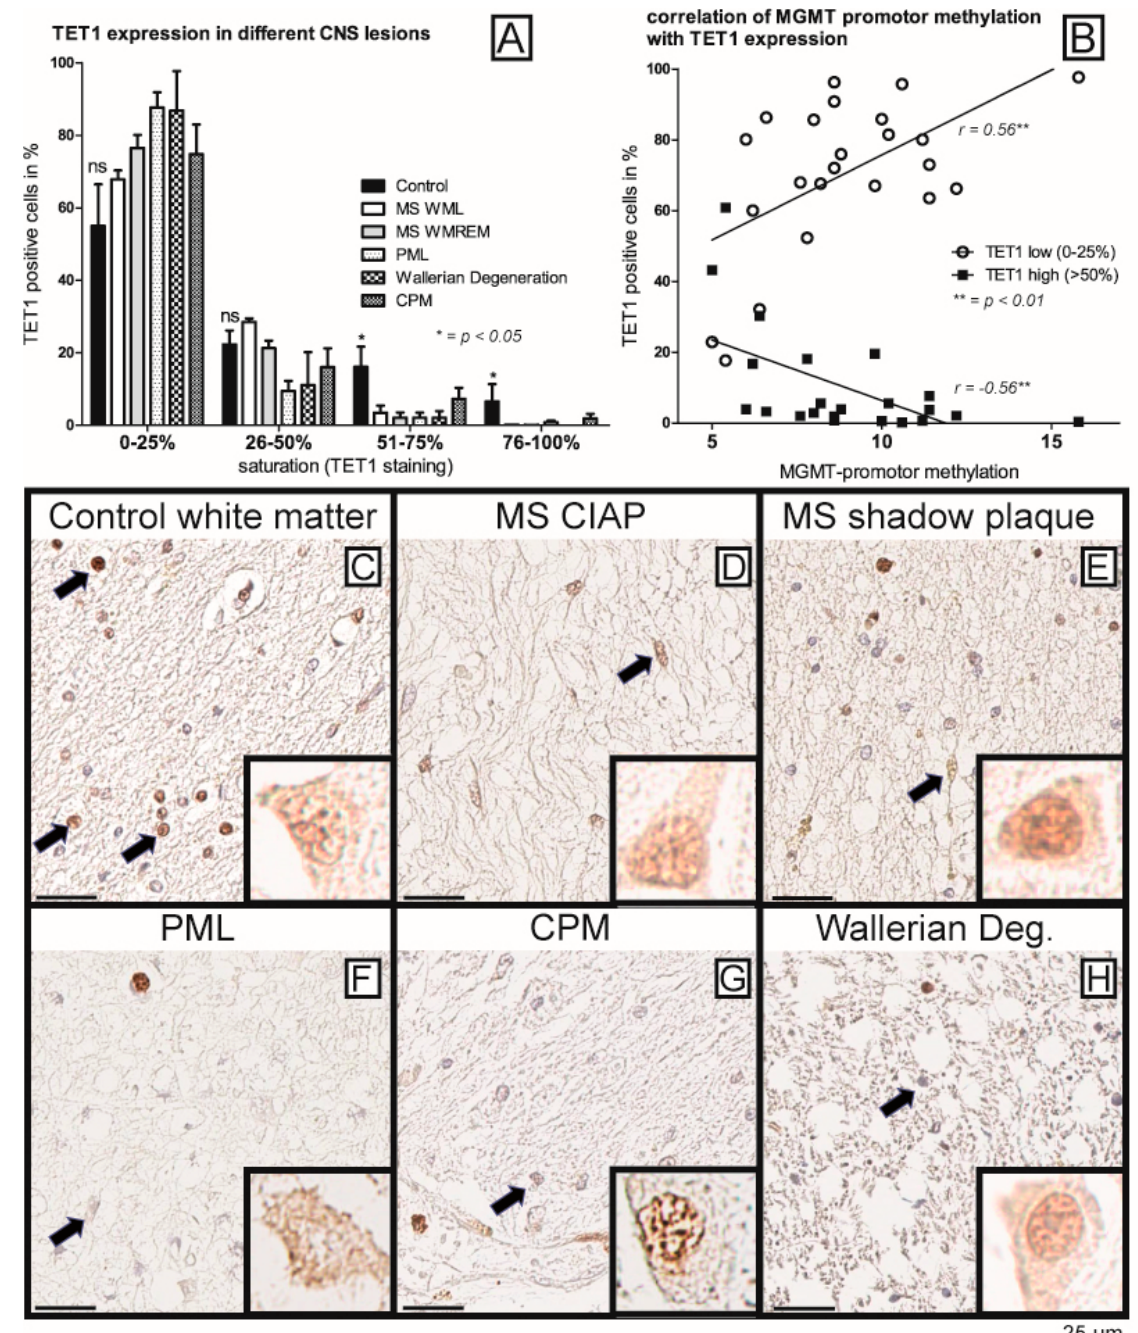
Figure 3. Reduction in TET1 staining in samples with enhanced MGMT promoter methylation. In control samples ( A , C ) a broad spectrum of TET1 expression was detectable with numerous strongly TET1-stained glial cells (arrows). In samples with enhanced MGMT methylation ( D – H ), glial cells with little or no TET1 expression were mainly detected, whereas strongly TET1-positive glial cells, i.e., glial cells with high TET1 expression were hardly detectable compared with controls ( D ). MS chronic inactive plaque, ( E ). MS shadow plaque; ( F ). PML, ( G ). CPM; ( H ). Wallerian degeneration). In all samples, the neurons in the same sections with a similar positive staining of MGMT served as an internal positive control to exclude staining artifacts (inset in ( C – H ), edge length 15 µ m each). ( B ): The subset of glial cells with strong TET1 expression (lower panel) shows a significant negative correlation (Pearson r= − 0.56, p < 0.01) with the level of MGMT promoter methylation, while vice versa the subset of glial cells with weak TET1 expression (upper panel) shows a significant positive correlation (Pearson r = 0.56, p < 0.01) with the level of MGMT promoter methylation. Scale bar = 25 µm. It is noteworthy that the percentage of high TET1-expressing glial cells correlated negatively with the MGMT promoter methylation rate (Figure 3B, lower panel), while conversely, that of low TET1-expressing glial cells (Figure 3B, upper panel) was positively correlated with it.